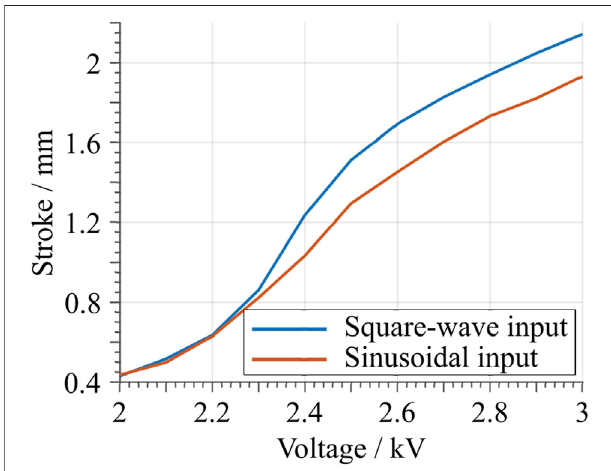
FIGURE 12 | Maximum stroke as a function of the applied voltage amplitude. The blue curve represents the values obtained from the square wave input signal, while the red curve is obtained from the sinusoidal input.